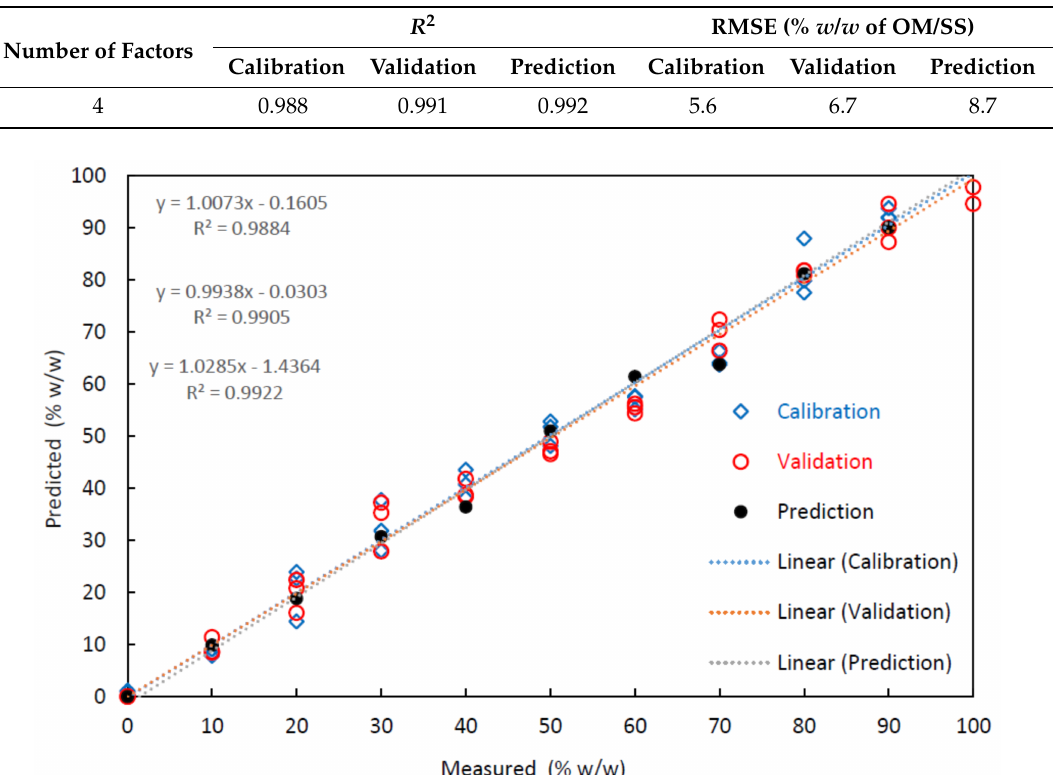
Figure 3. Illustration of the quality of prediction models obtained by Fourier transform infrared spectroscopy (FTIR) for the observed and estimated values for the different mixtures of Salmo salar (SS) and Onconrhynchus mykiss